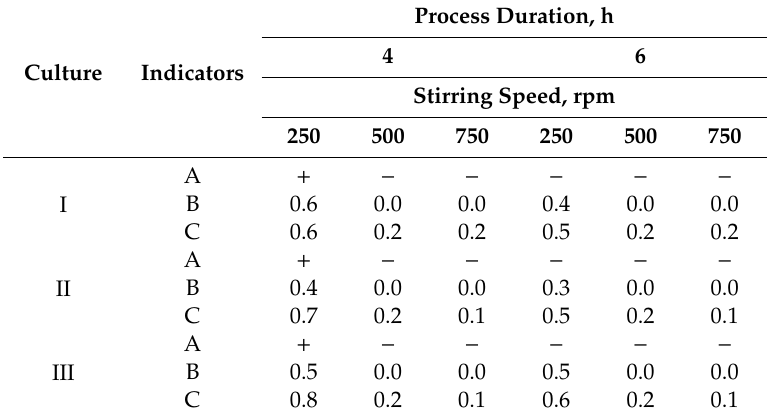
Table 2. The e ffi ciency of the ultrafiltration of a lipid complex isolated from the microalgae